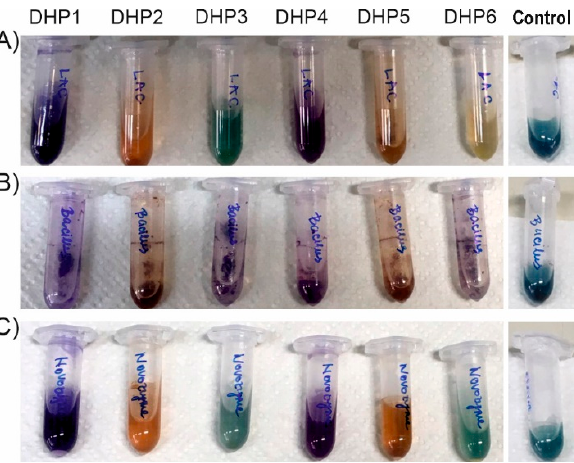
Figure 5. Colours of reactions after 18 h incubation with different types of laccases ( A ) Tv Lacc; ( B ) Bacillus Lac; ( C ) Novozym 51003; Control reactions with enzymes and ABTS mediator without DHP substrate.